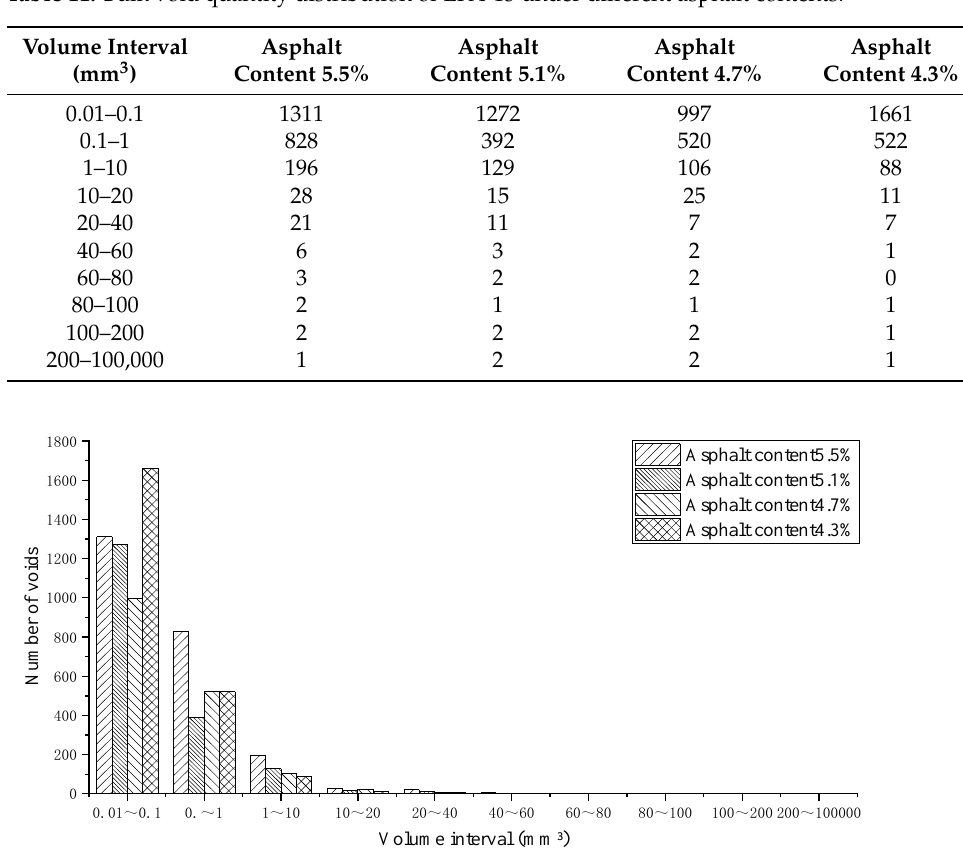
Table 11. Bulk void quantity distribution of EPA-13 under different asphalt contents.